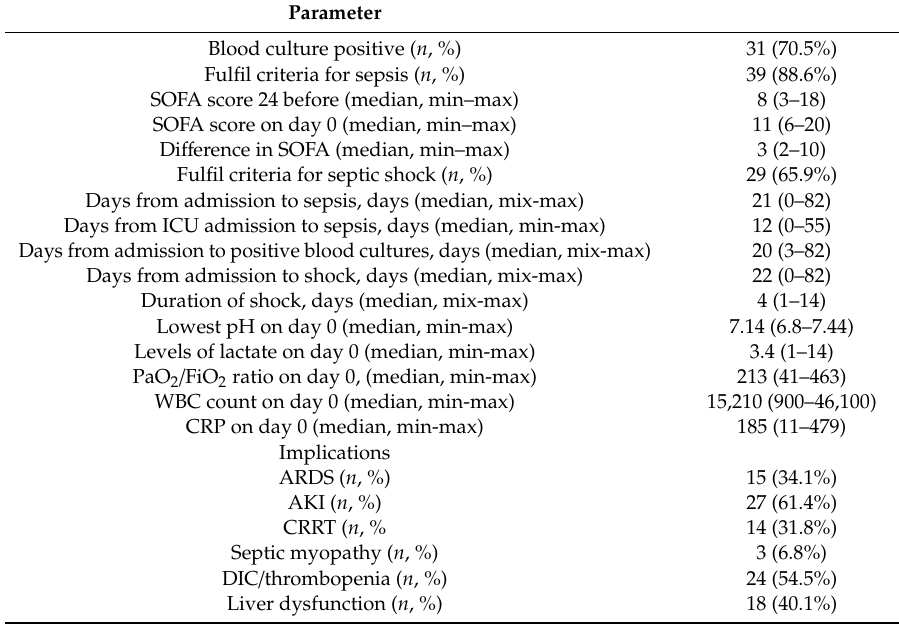
Table 2. Characteristics of AB